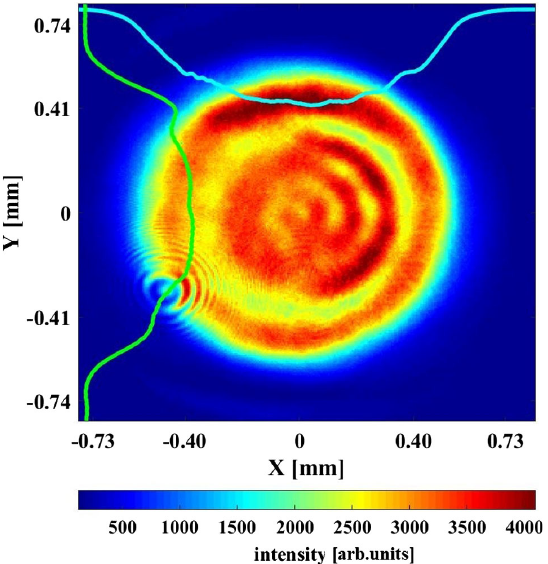
FIG. 2. A measured intensity map of the cathode laser pulse. (blue) is similar to a Gaussian fit (dotted green) with slight deviations. The measured pulse length is about 3 ps rms.